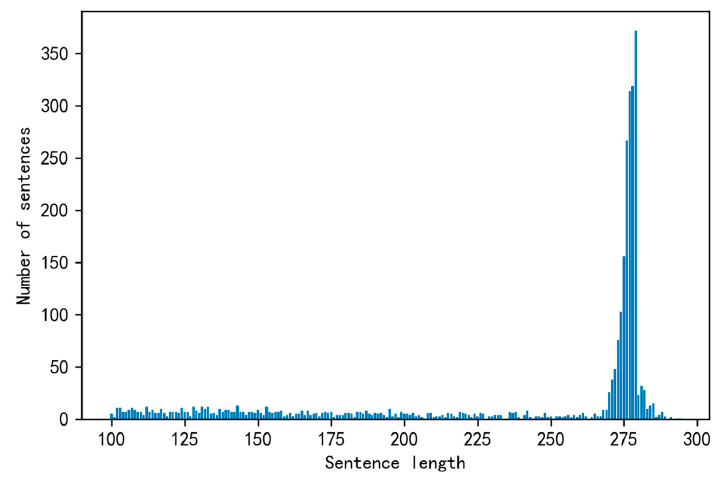
Figure 2. Length of the comment text of Mutianyu Great Wall in Beijing, China.